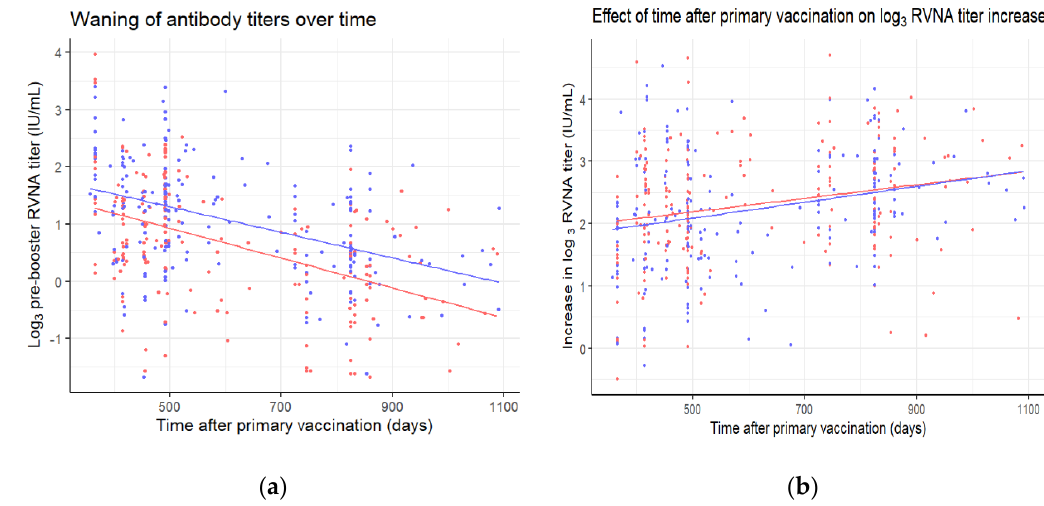
Figure 4. ( a ) Pre-booster log 3 titers and ( b ) differences in pre- and post-booster log 3 titers plotted against the time after primary vaccination for the three-visit (red) and two-visit (blue) schedule. Linear regression lines were plotted for the data of each of the schedules in their corresponding color.